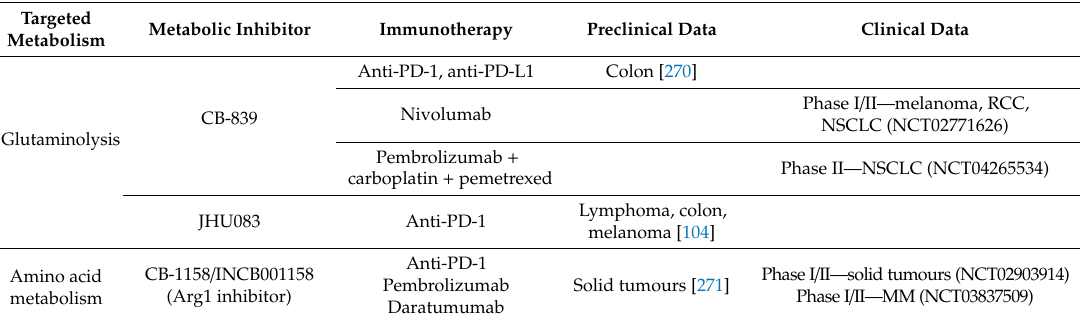
Table 4. Metabolic inhibitors in combination with